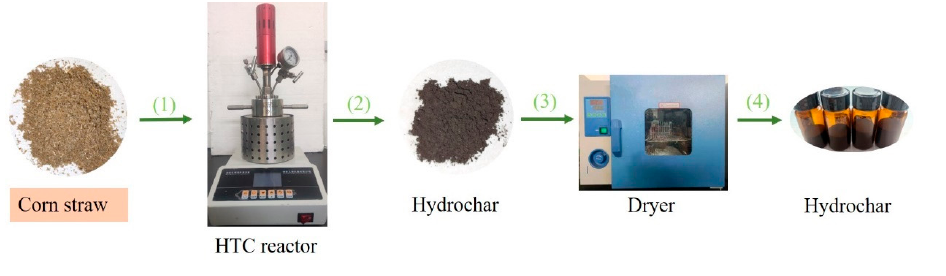
Figure 1. Schematic diagram showing the preparation of hydrochar.